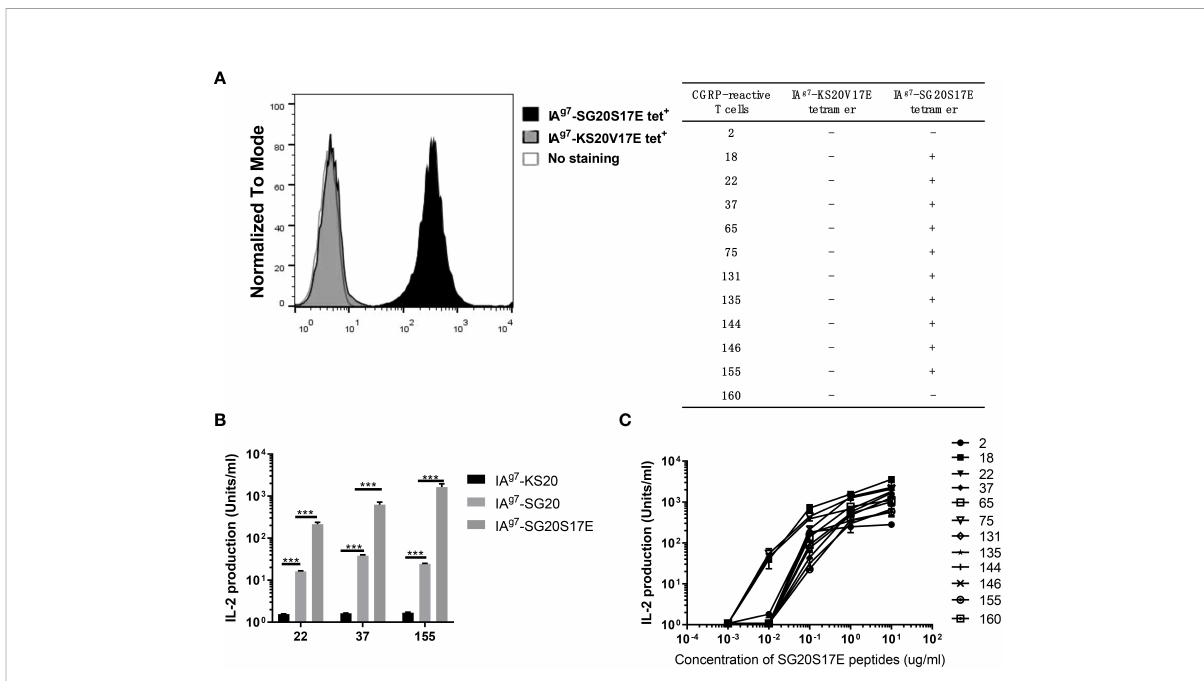
FIGURE 5 CGRP-speci fi c T cellhybridomas did notcross-react with the KS20peptide.20CGRP-speci fi c T cellhybridomas weregenerated as described in materials andmethods. (A) IA g7 -SG20S17E tetramersand IA g7 -KS20V17E tetramerswereused tostain these CGRP reactive T cellhybridomas and unstained T cells as the negative control. The table showed the tetramer bindingwith the CGRP reactive T cell hybridomas. “ - ” represents no binding; “ + ” represents binding signi fi cantly. (B) ICAM + B7 + SF9 insect cells expressingIA g7 -WT SG20 or IA g7 -SG20S17E wereused as APCsto stimulate three representative CGRP-reactive T cell hybridomas 22, 37, and 155.Results arethe means ± SEM oftriplicate wells. (C) M12C3 G7 cells incubated with different concentrations of SG20S17E peptide stimulated the CGRP reactive T cell hybridomas. * P < 0.05,** P < 0.01, *** P <